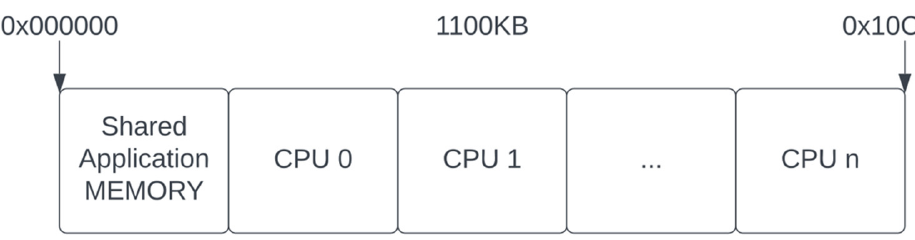
Figure 14. The abstract diagram of the multi-processor generator.